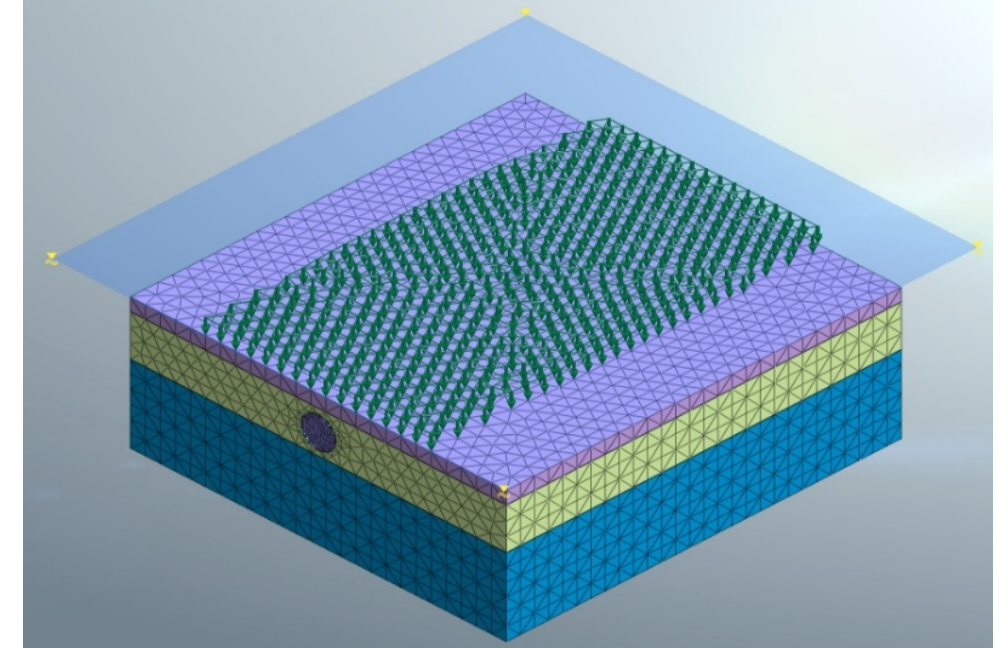
Figure 14. F.E. simulation of backfilling